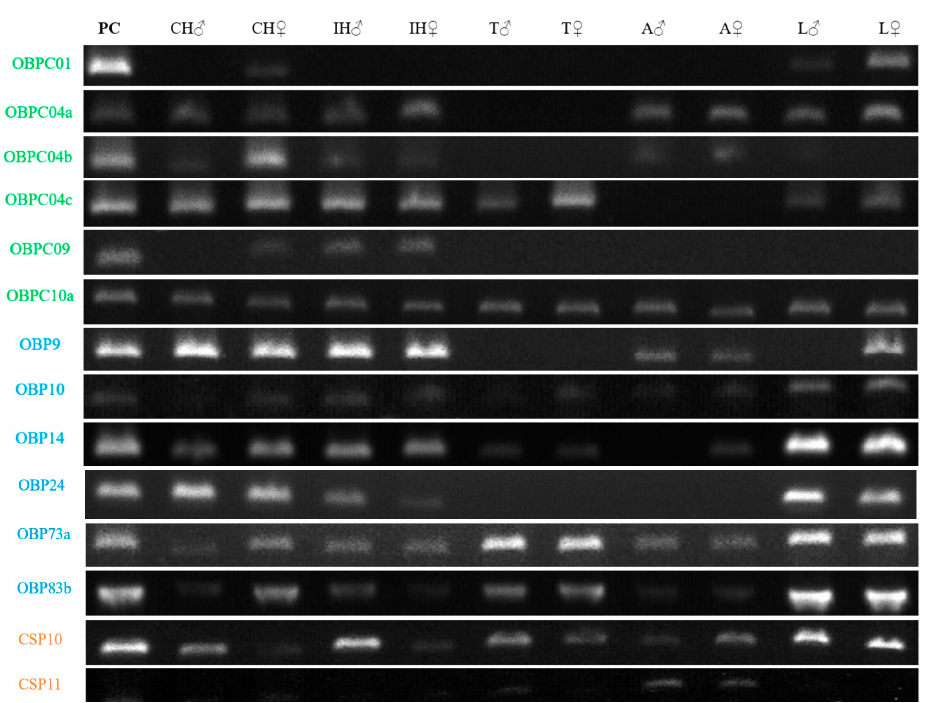
Figure 5. RT-PCR expression pattern by tissue and sex. Different patterns can be observed per tis- sue and sex. PC: positive control (head pool of both sexes’ complete heads): CH: complete heads (with antennae); IH: incomplete head (without antennae); T: thorax; A: abdomen; L: legs. Green names correspond to Minus-C OBPs, and blue to classic OBPs.